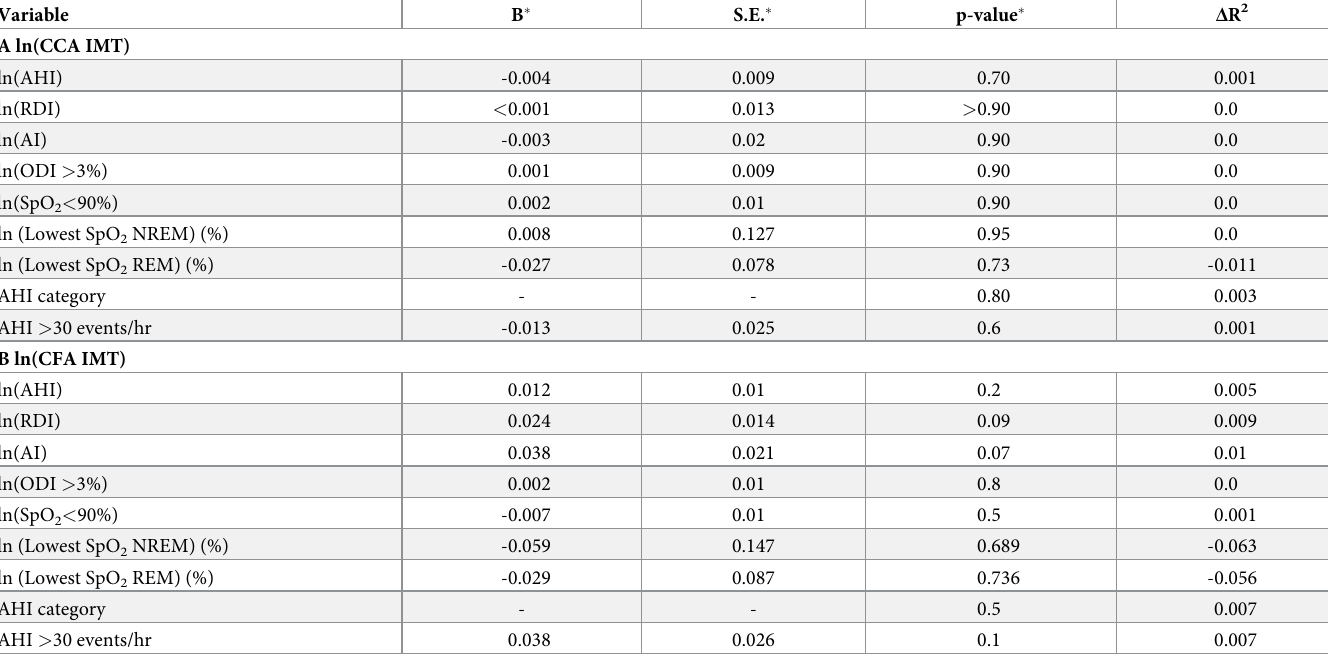
B � = unstandardized beta coefficient adjusted for base model; S.E. � = standard error of B � ; Δ R 2 is the incremental change in R 2 after addition of the SDB variable to the Base Model calculated as (SDB model R 2 - Base Model R 2